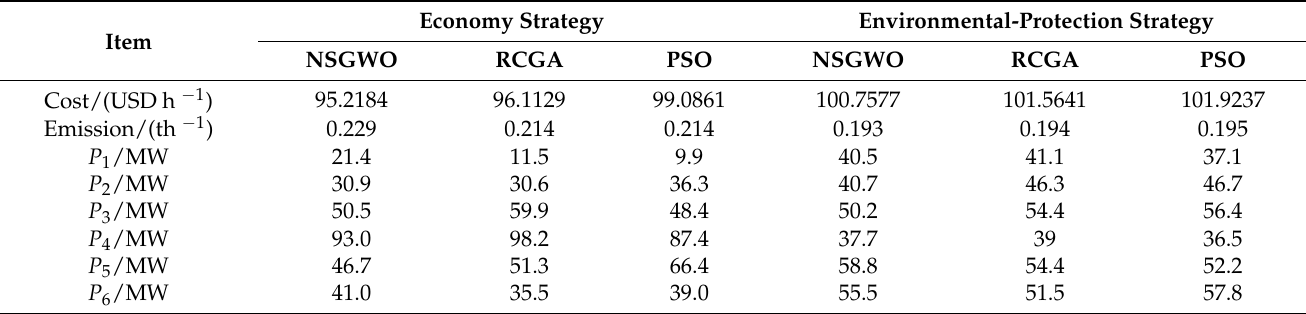
Table 7. Optimization results of load dispatch under economy and environmental-protection strate- gies for coal-fired power plant considering valve-point effect of steam turbines.